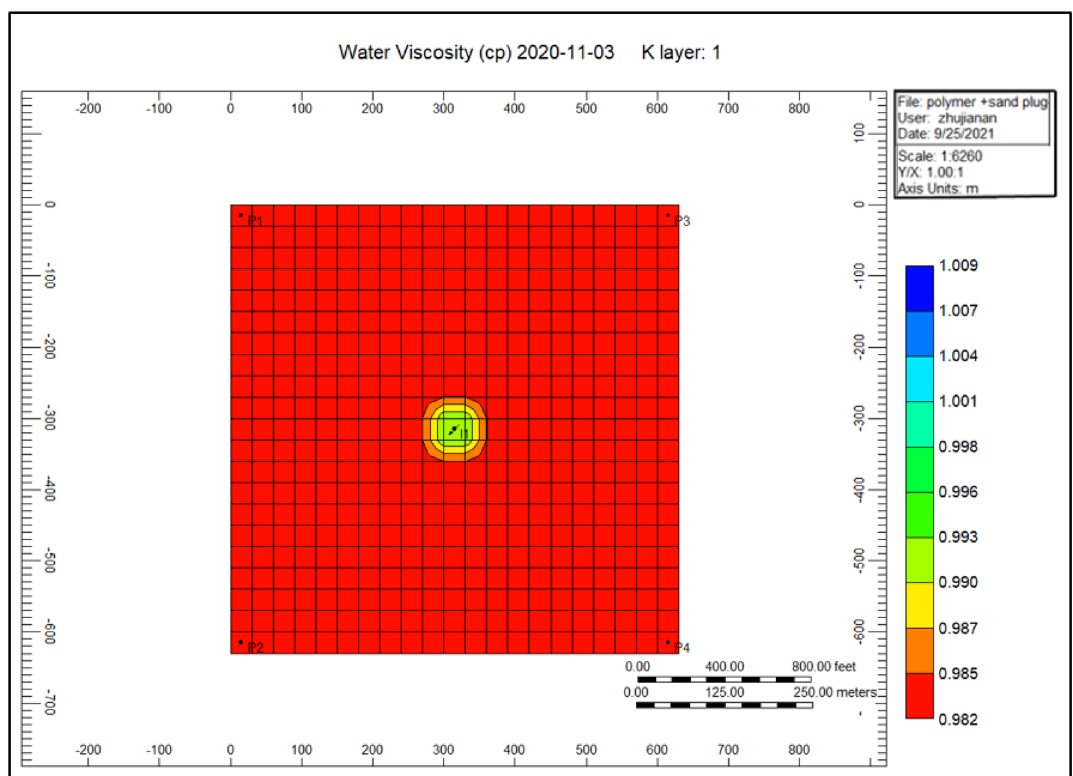
Figure 25. Shows the water viscosity of the cross-linked gel achievement 2020-11-03 CMG STARS 2017.10 URL: https:// www. cmgl. ca/.